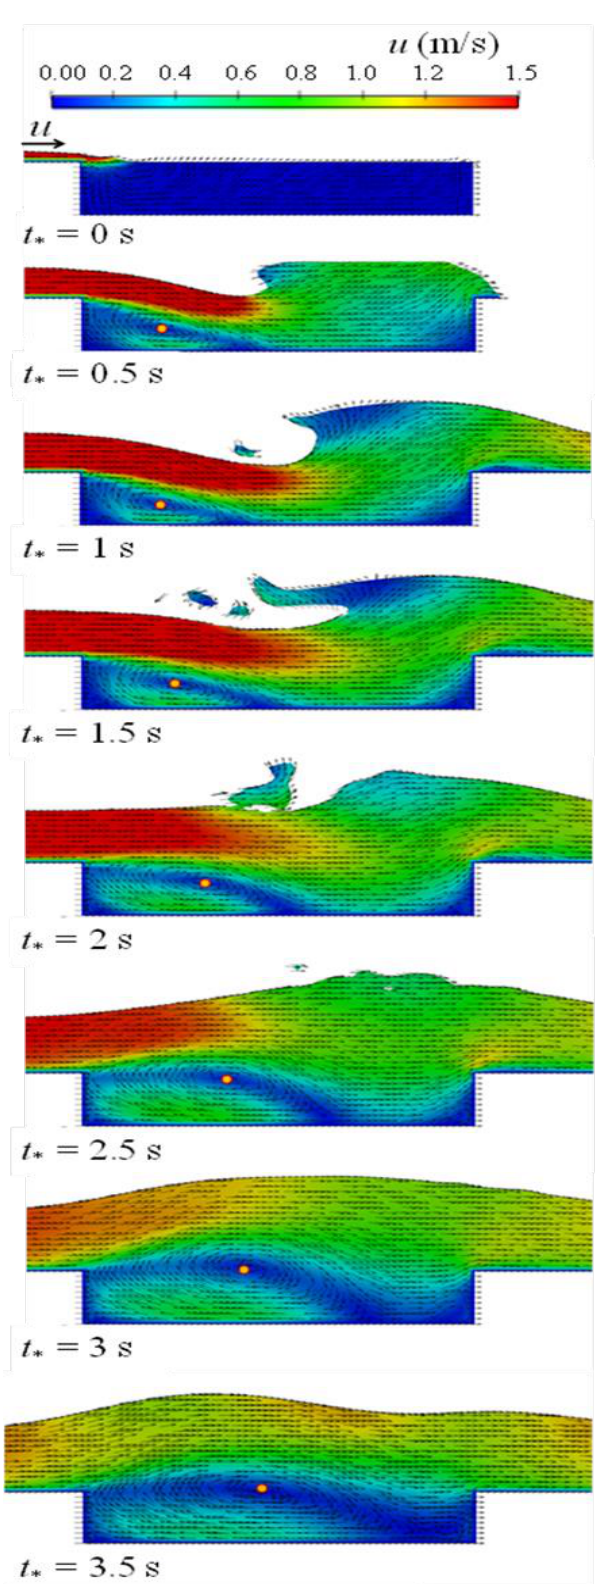
Figure 11. Variations of the contour plots of velocity and velocity vector fields with time, for a bore from an impoundment with a depth of d o = 0.3 m, passing over a canal with a width of w = 0.6 m and a depth of d = 0.10 m. The dots in the contour plots show the eye of the vortex.